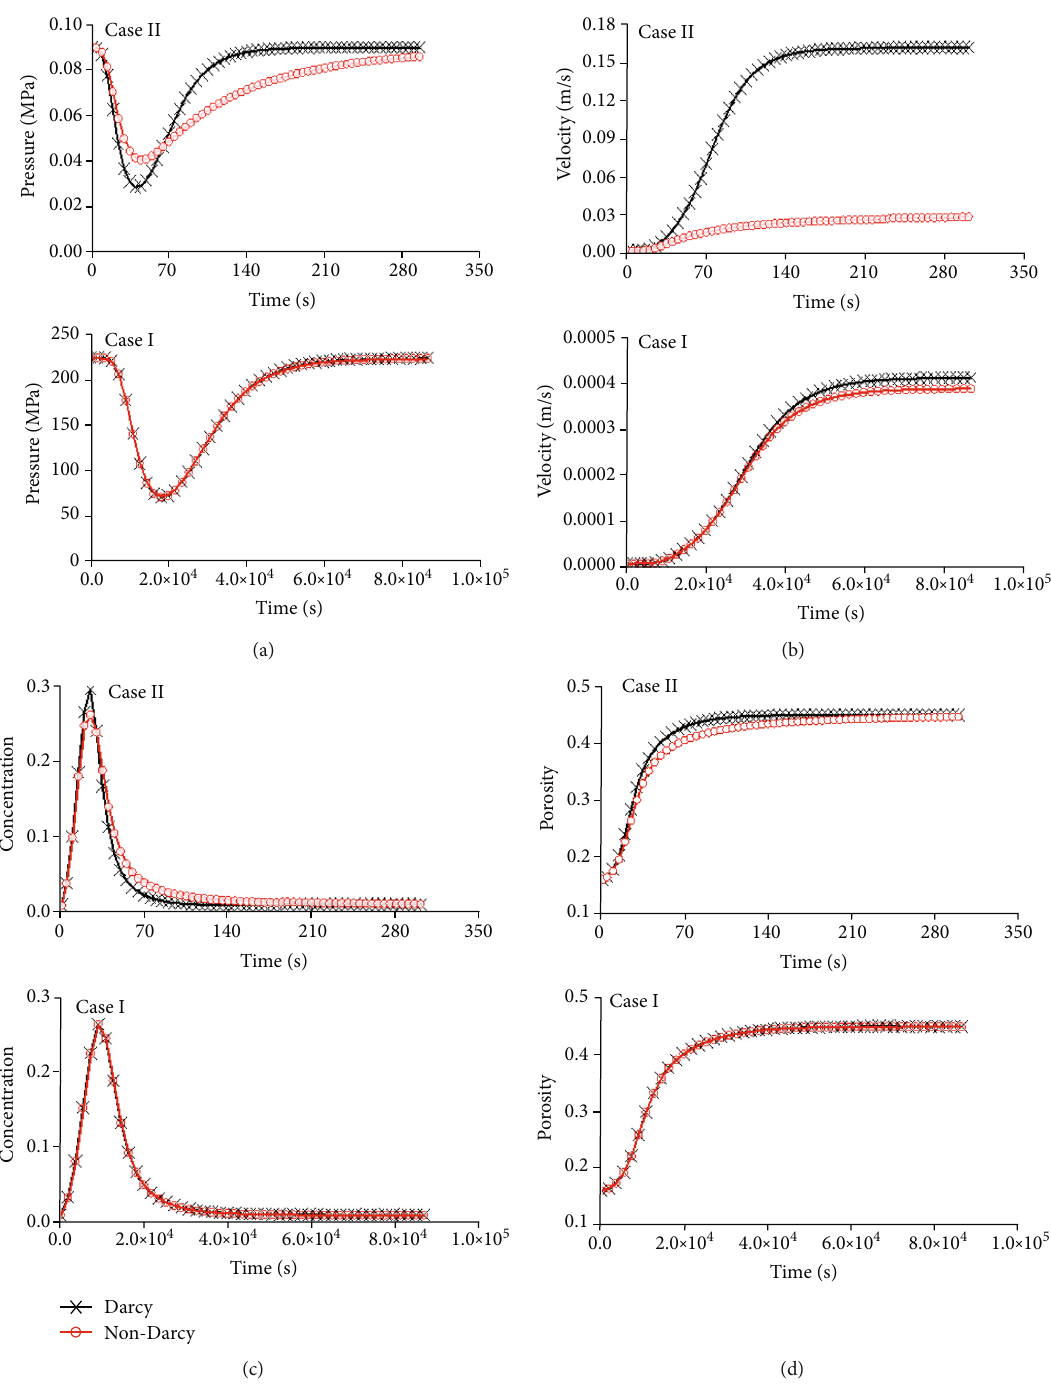
Figure 3: Evolution of pressure, average fl ow velocity, concentration, and porosity with time: (a) pressure, (b) average fl ow velocity, (c) concentration, and (d)